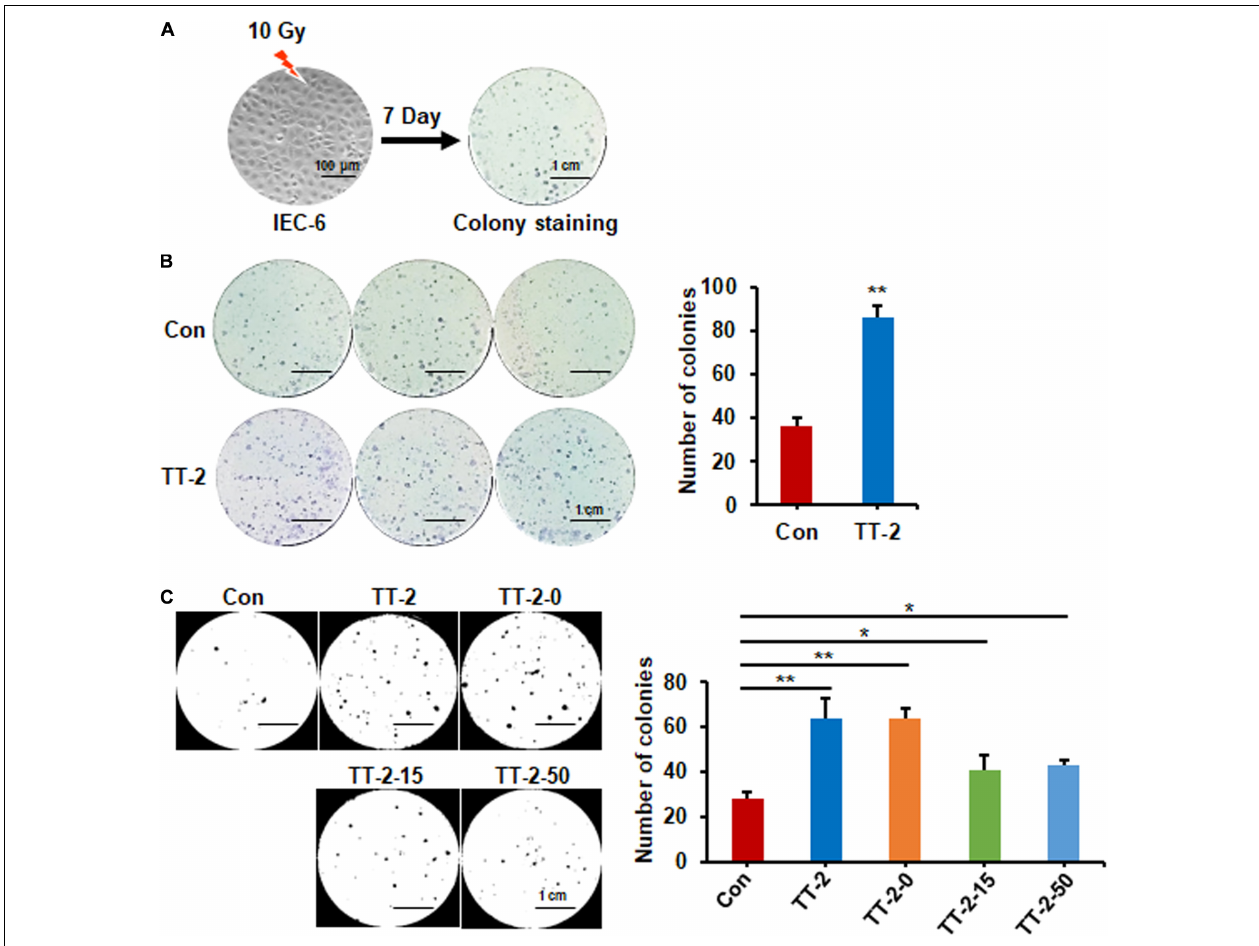
FIGURE 1 | Active fraction of Trillium tschonoskii (TT) promoted colony formation of rat intestinal epithelial cell line 6 (IEC-6) cells. (A) Schematic diagram of colony formation by IEC-6 cells after 10 Gy irradiation. (B) Representative colony image and colony numbers formed by IEC-6 cells after 10 Gy irradiation and addition of H 2 O, or TT-2 to the culture medium (** p < 0.01, scale bar = 1 cm). (C) Representative colony staining image and colony numbers formed by IEC-6 cells after 10 Gy irradiation and addition of TT-2 or samples isolated after elution with different concentrations of ethanol (TT-2-0, TT-2-15, and TT-2-50) (* p < 0.05, ** p < 0.01, scale bar = 1